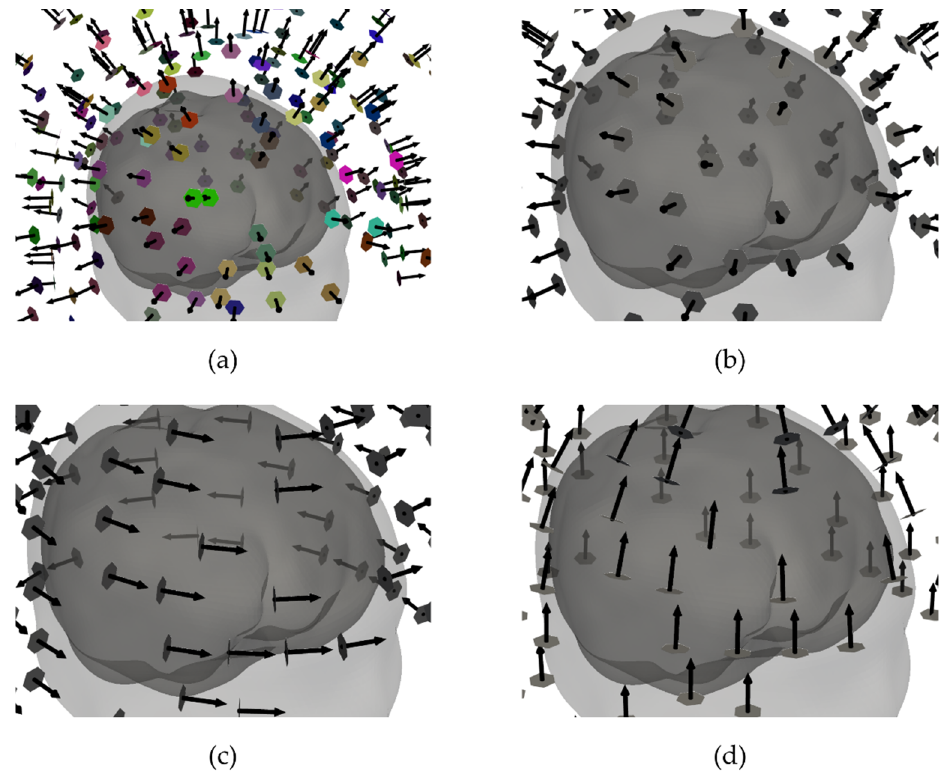
Figure 2. Different configurations of the SQUID measurement components for one selected subject: ( a ) the original Yokogawa system with 125 axial gradiometers magnetometers (SQUID-AXI-GRAD), ( b ) normal magnetometers (SQUID-NOR), ( c ) tangential magnetometers along the lines of latitude (SQUID-TAN-LAT) and ( d ) longitude (SQUID-TAN-LON). In the gradiometer system, the individual sensor pairs which form a gradiometer have the same color.